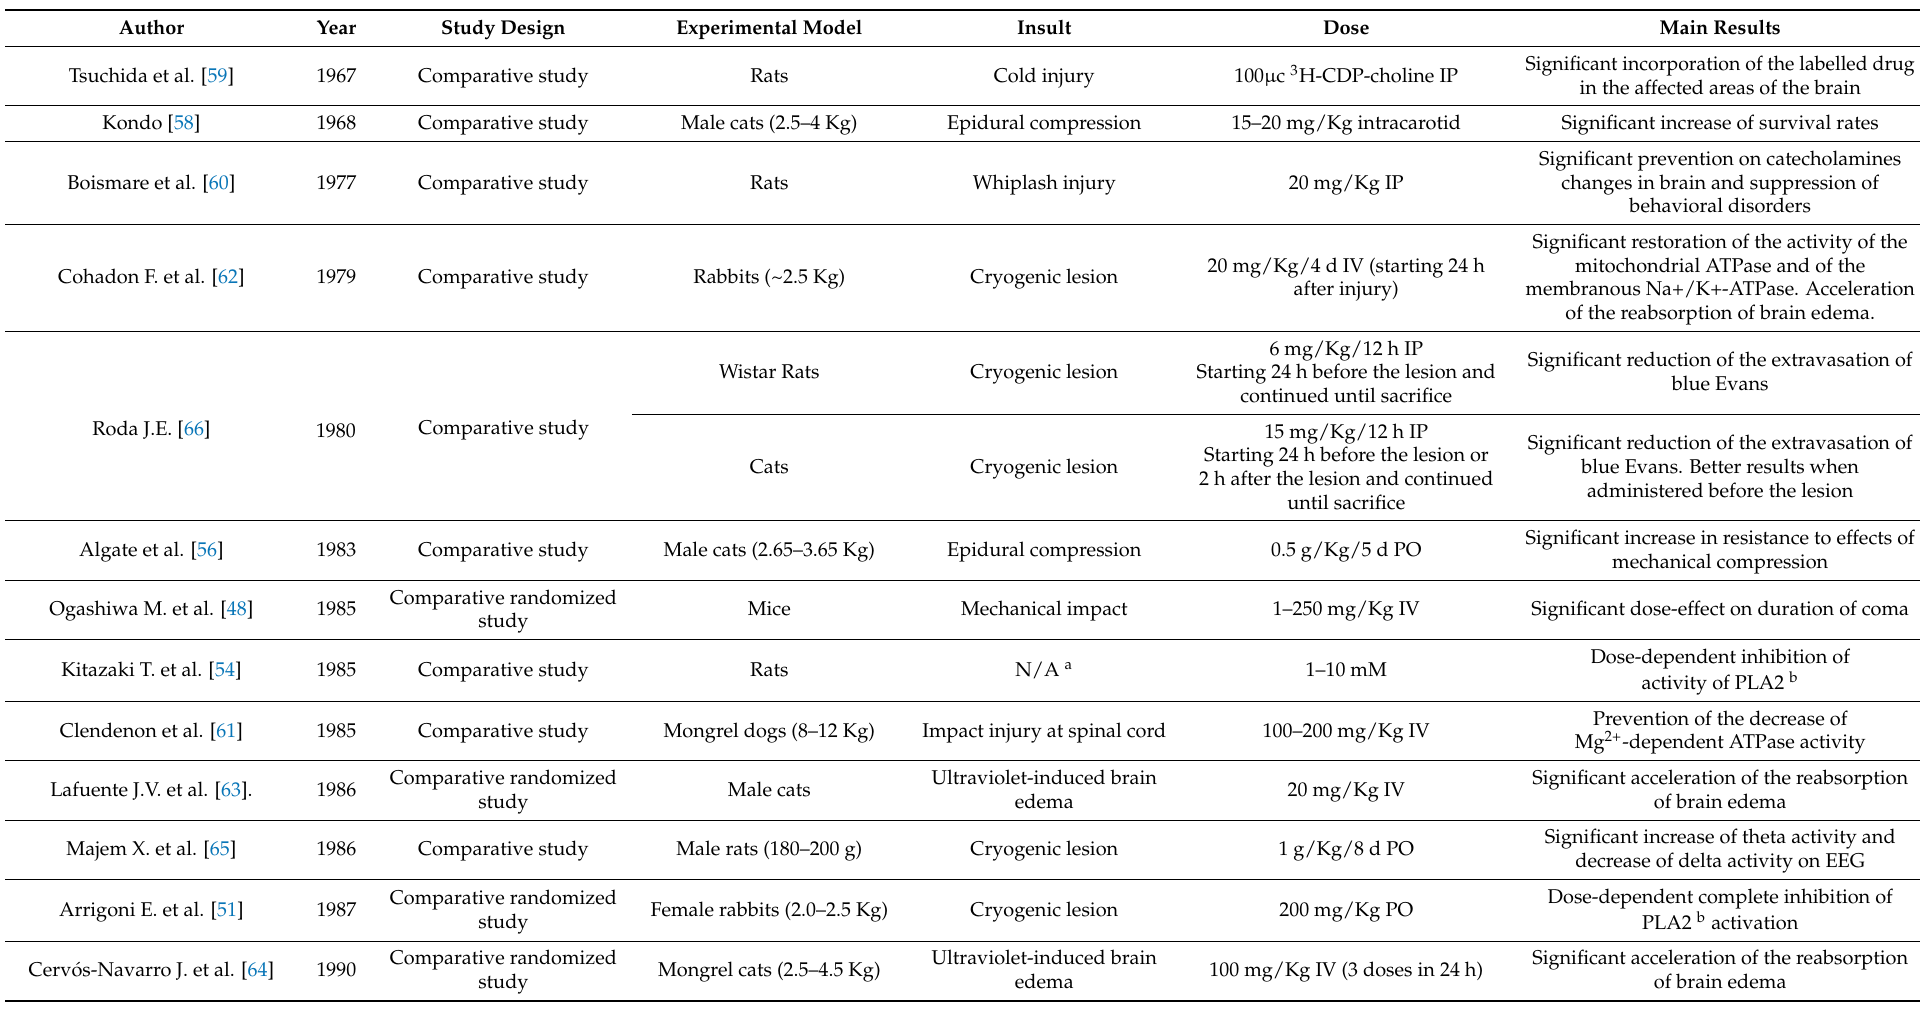
Table 1. Summary of preclinical studies evaluating the therapeutic efficacy and the mechanism of action of citicoline in